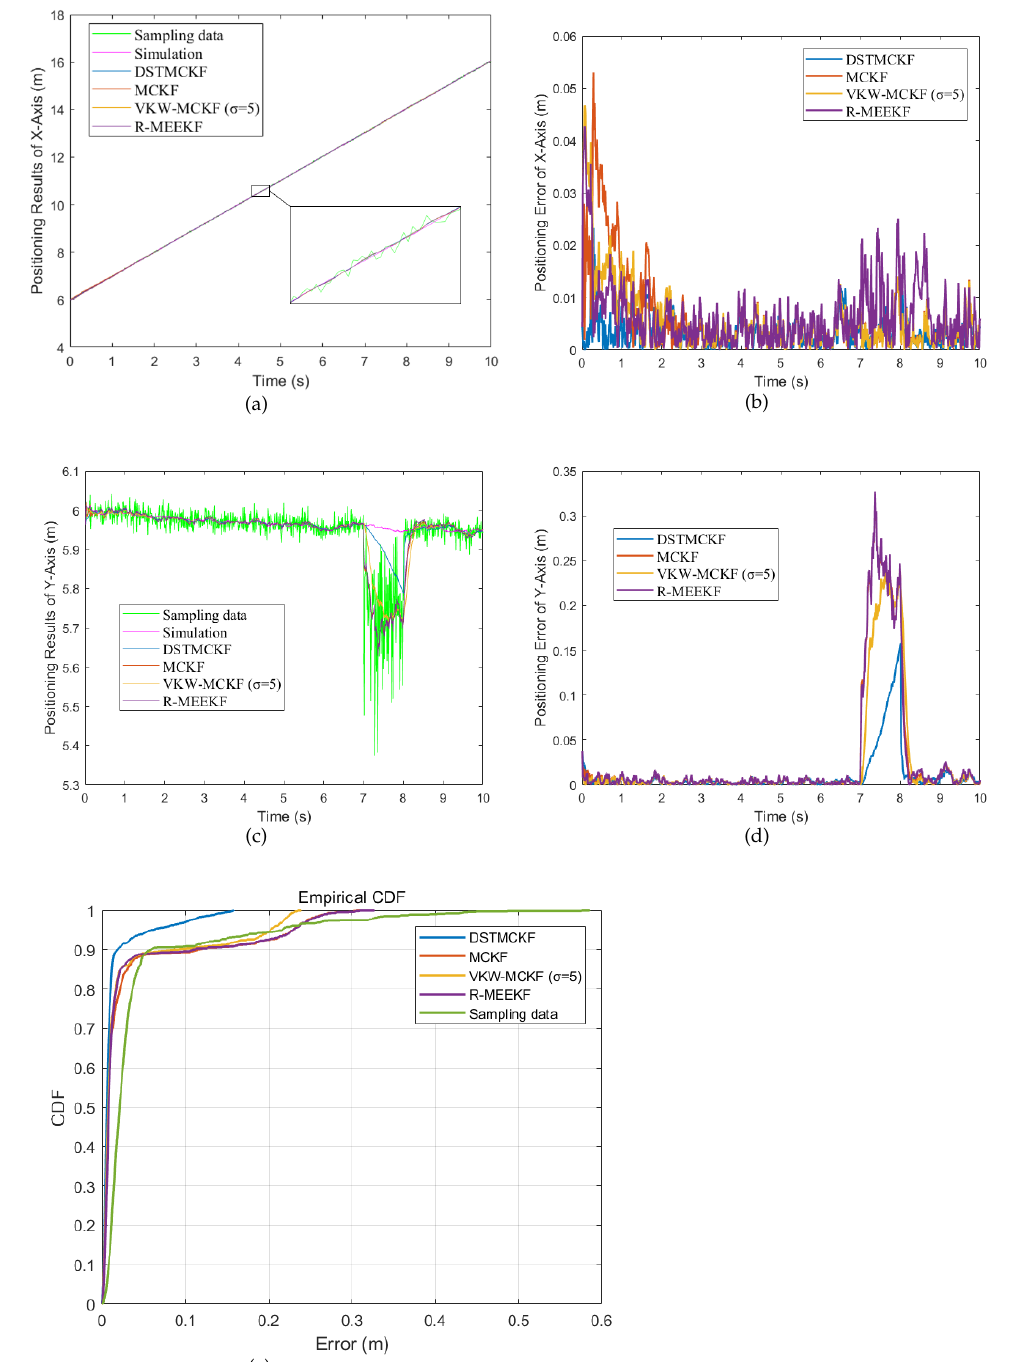
Figure 8. Simulation Results in Case (3). ( a ) Positioning result of X-label when σ = 1.2; ( b ) error of X-label when σ = 1.2; ( c ) positioning result of Y-label when σ = 1.2; ( d ) error of Y-label when σ = 1.2; ( e ) CDF of each filter when σ =